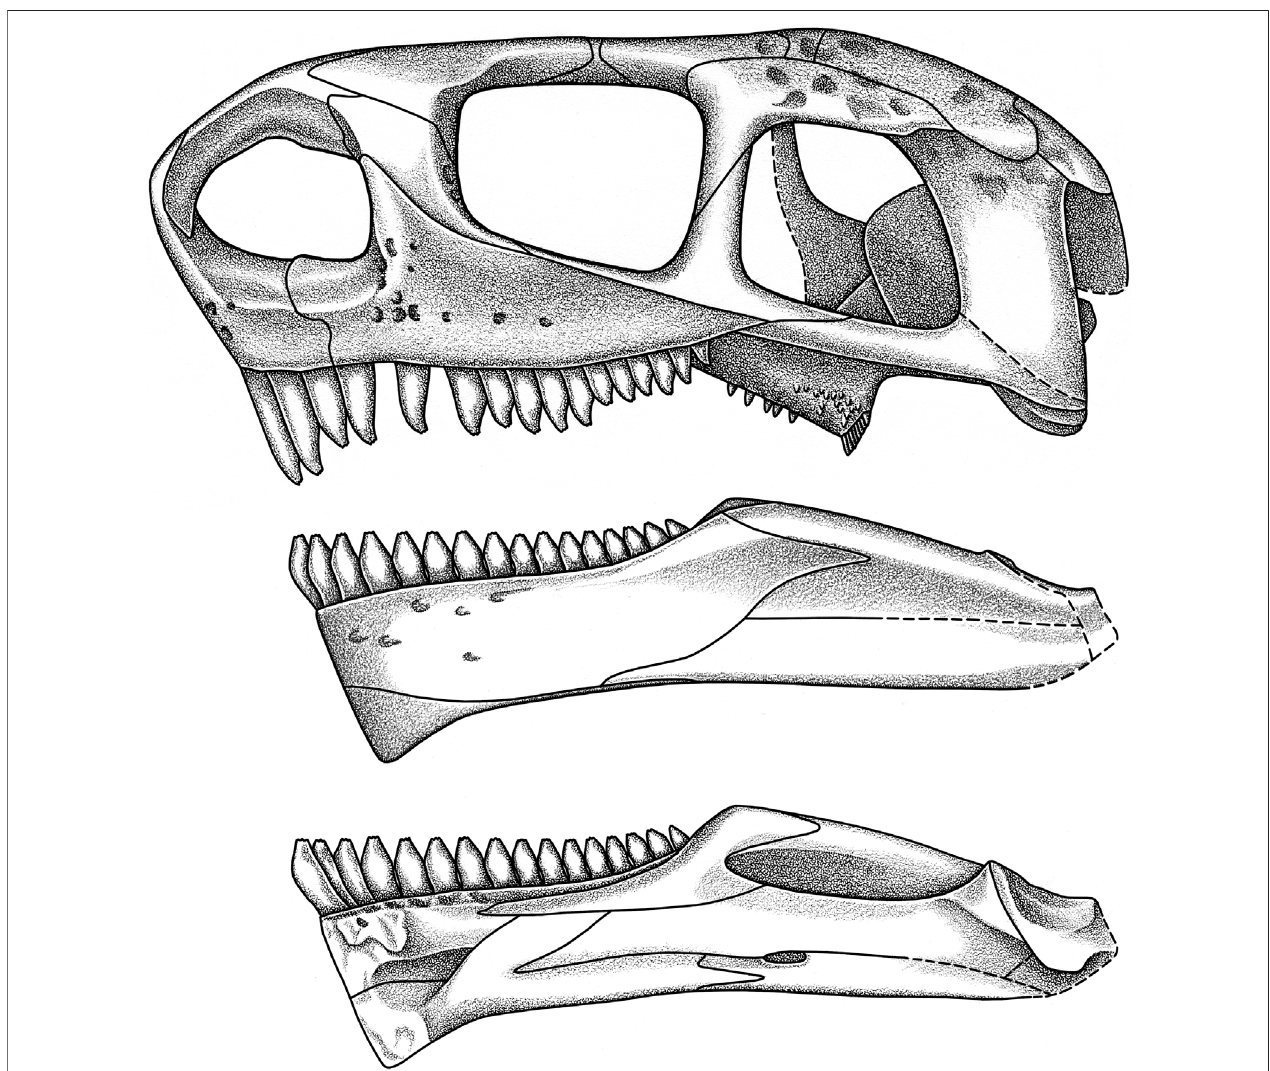
FIGURE 4 | Cotylorhynchus romeri . Skull reconstruction in left lateral view, and medial and lateral views of mandible.